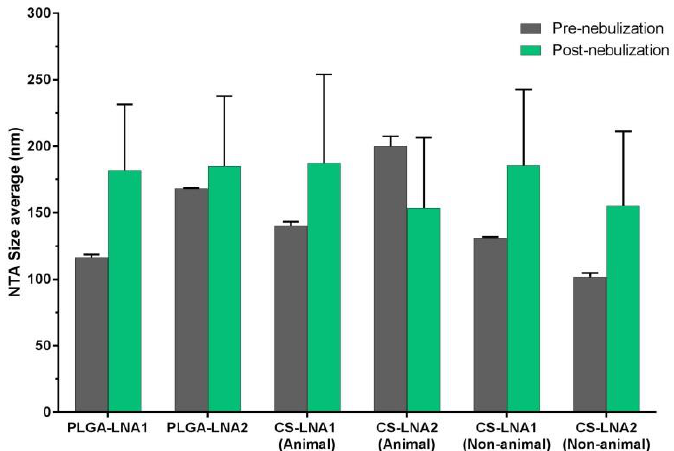
Figure 9. Effect of nebulization in LNAs-NPs. All LNA-NPs were measured before and after nebulization using NTA technique. The Aerogen Solo vibrating mesh nebulizer (Aerogen, Galway, Ireland) was used to generate the aerosol.